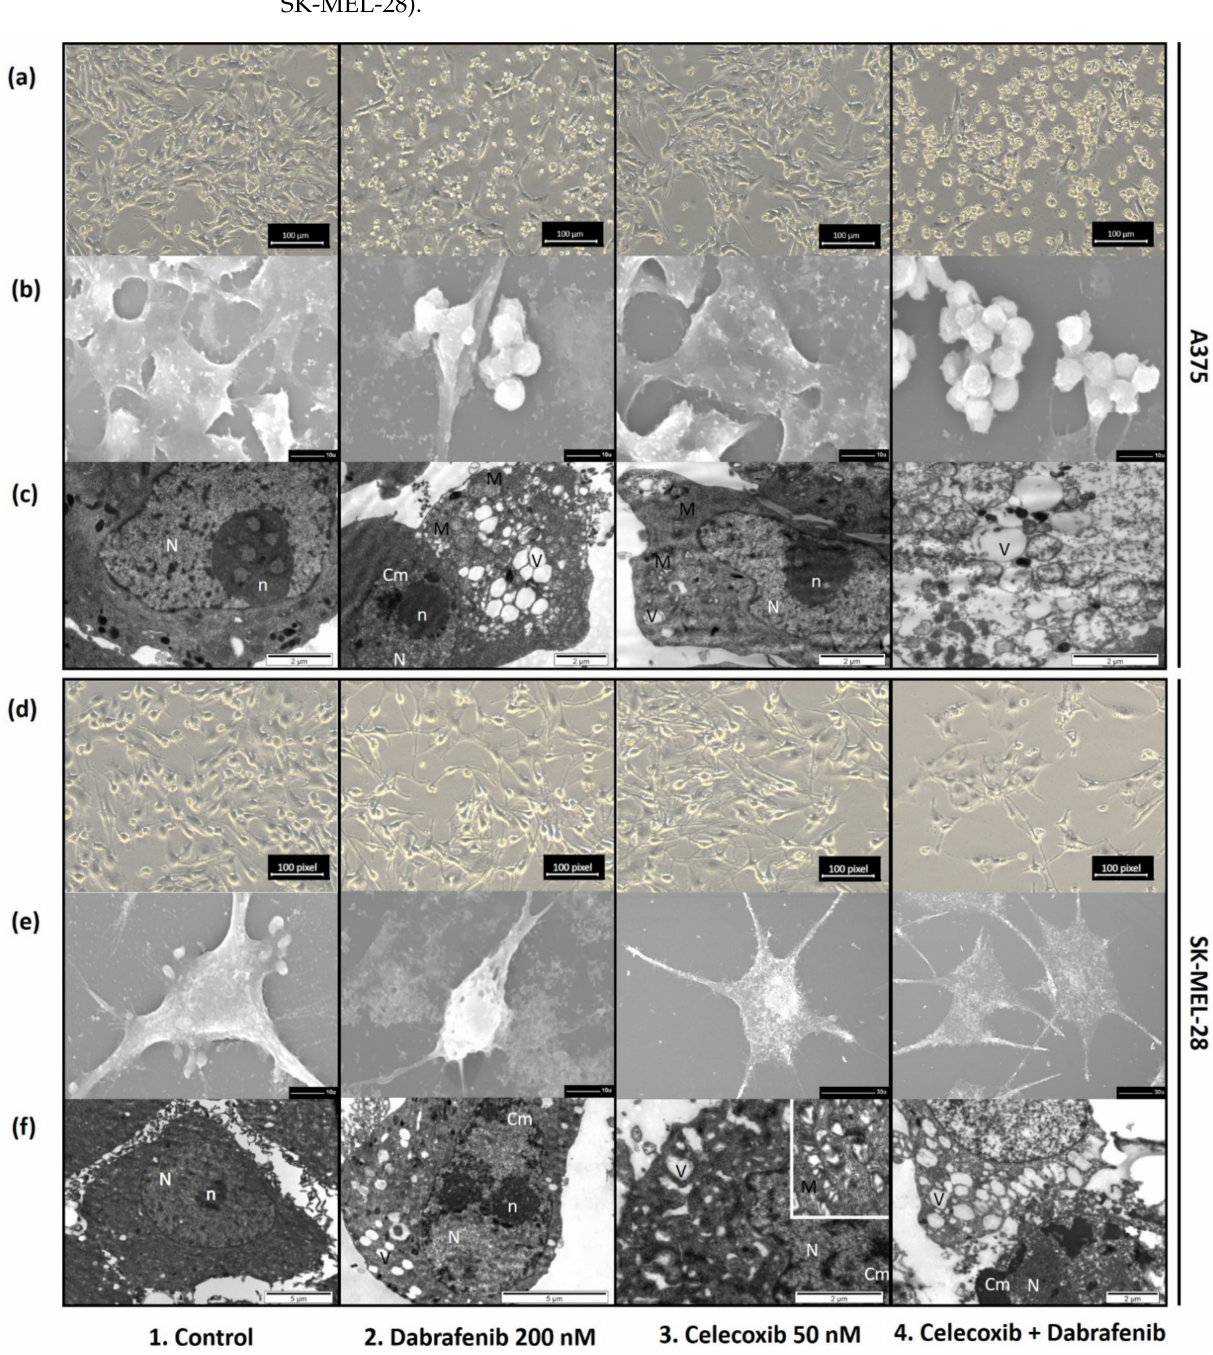
Figure 3. External and internal melanoma cells change after 72 h of celecoxib and dabrafenib treat- ment. During treatment, cells were observed using an inverted light microscope (Olympus CKX41, Hamburg, Germany) and pictures were taken at the end of each protocol using a digital camera (Olympus E330) ( a , d ). Moreover, some cells were seeded on glass coverslips in order to be further evaluated using SEM ( b , e ) and cells from the supernatant were collected and used for evaluation of internal changes using TEM ( c , f ). Scale bars = 100 µ m ( a , d ), 10 µ m ( b , e1 , e2 ), 2 µ m ( c , f3 , f4 ), 30 µ m ( e3 , e4 ), 5 µ m ( f1 , f2 ). N, nucleus; n , nucleolus; V, vacuoles; Cm, chromatin; M,